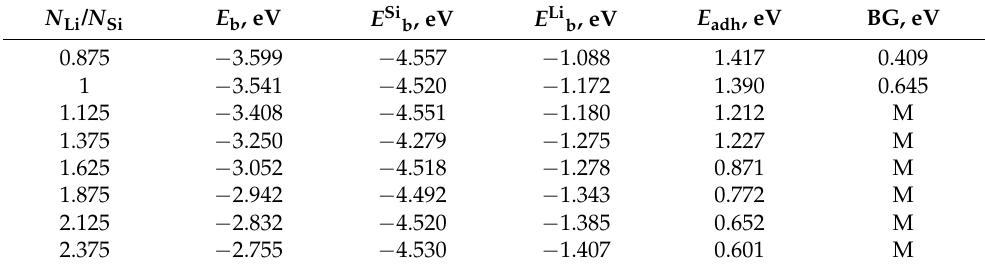
Figure 3. Partial spectrum of electronic states of two-layer silicene obtained after the replacement of 2 Si atoms belonging to each of the lower sublattices by phosphorus. Adapted with permission from Ref. [48]. 2020, Springer.